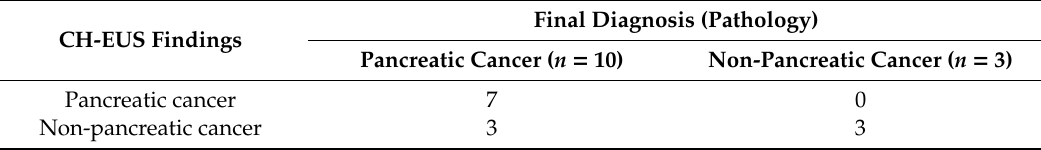
Table 6. Diagnostic ability of CH-EUS for pancreatic lesions measuring ≤ 10